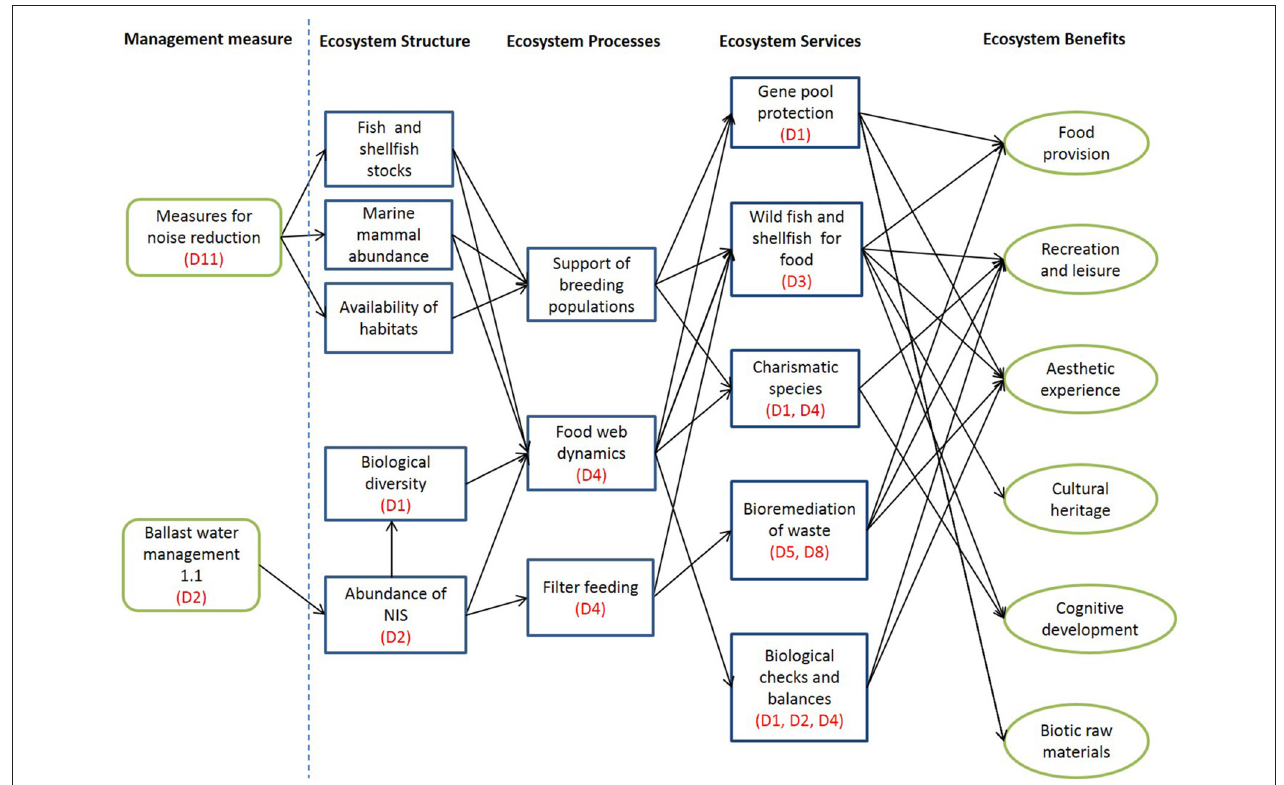
FIGURE 2 | Links between management measures and ecosystem structure, services and benefits. Services and benefits as per Hattam et al.